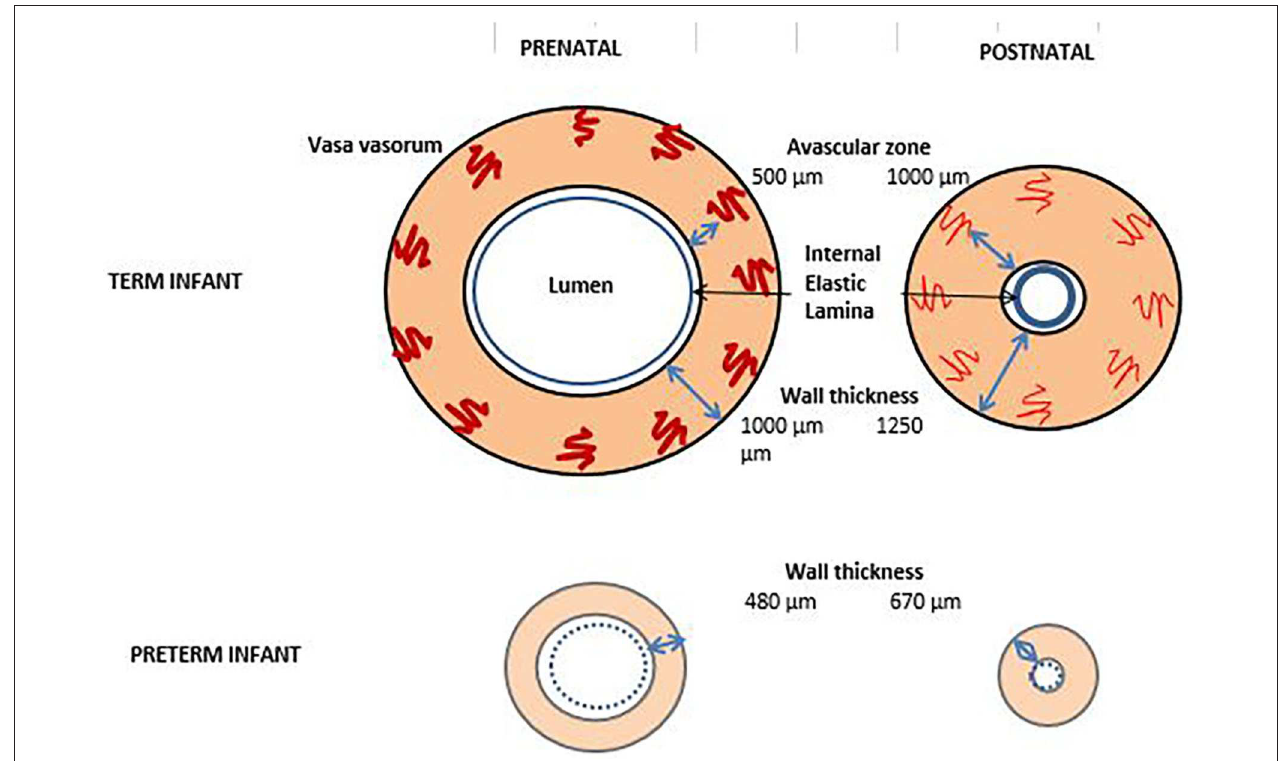
FIGURE 3 | Vaso vasorum in term and preterm infants before and after birth. By the obliteration of vaso vasorum, the thickness of the vaso vasorum increases after birth and the lumen shrinks. In the preterm infant, vaso vasorum are absent or very scarce and the elastic lamina is thin [Figure adapted from